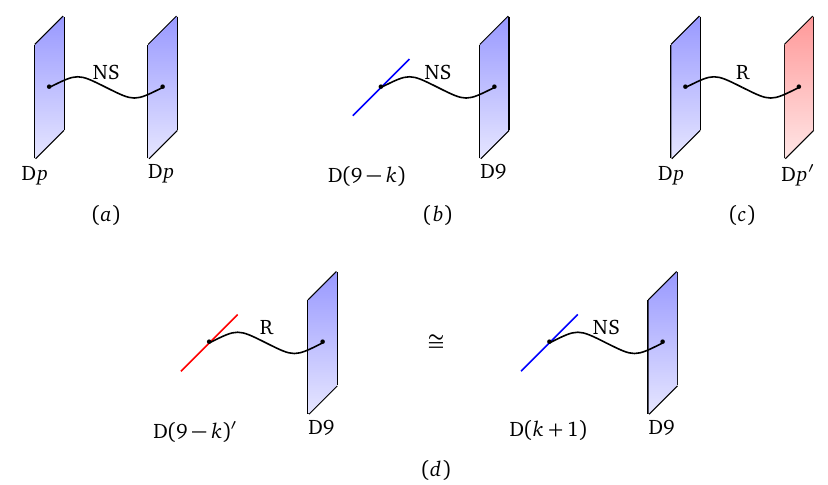
Figure 3: ( a ) A pair of D p -branes with an NS sector string stretched between them; ( b ) an NS sector string stretched between a D ( 9 − k ) - and D9-brane; ( c ) an R sec- tor string stretched between a D p - and D p (cid:48) -brane; ( d ) an R sector string stretched between a D ( 9 − k ) (cid:48) - and D9-brane, which can be thought of as an NS sector string stretched between a D ( k + 1 ) - and D9-brane, as far as the behavior of the fermion zero modes is